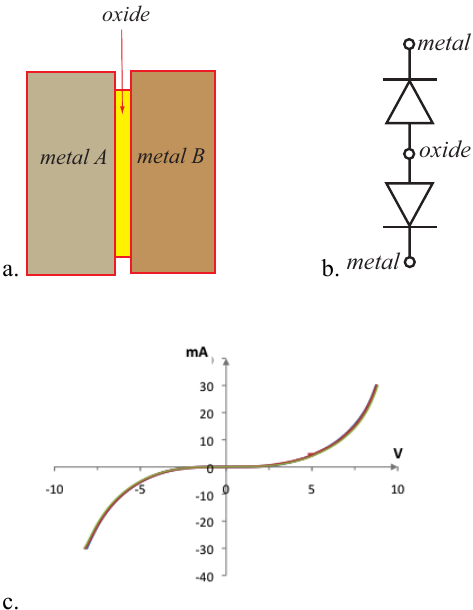
Figure 4:. The metal-oxide-metal experiment. a. Two steel disk with iron oxide grown on their facing surfaces. b. The MOM diode model. c. The I-V characteristics